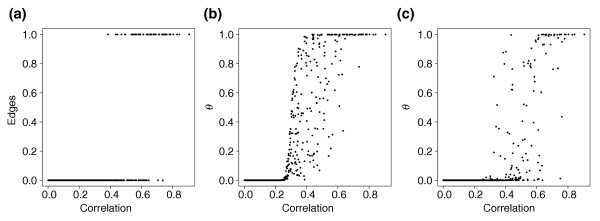
Comparison of the absolute pairwise correlation coefficients and the modified GGM approaches. (a) Selected edges in the frequentist modified GGM approach (0 and 1 denote absent and present edges respectively). (b) θ-values in the latent random graph approach. (c) θ-values after attaching 795 genes from other pathways.